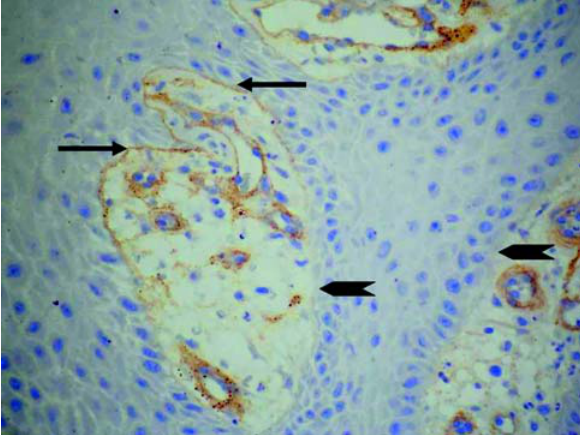
FIGURE 4- Epithelial hyperplasia and fibrosis observed under light microscopy and immunohistochemistry with type IV collagen staining. Basal membrane under the squamous epithelium is observed on some sites with discontinuity (arrows) (x400)